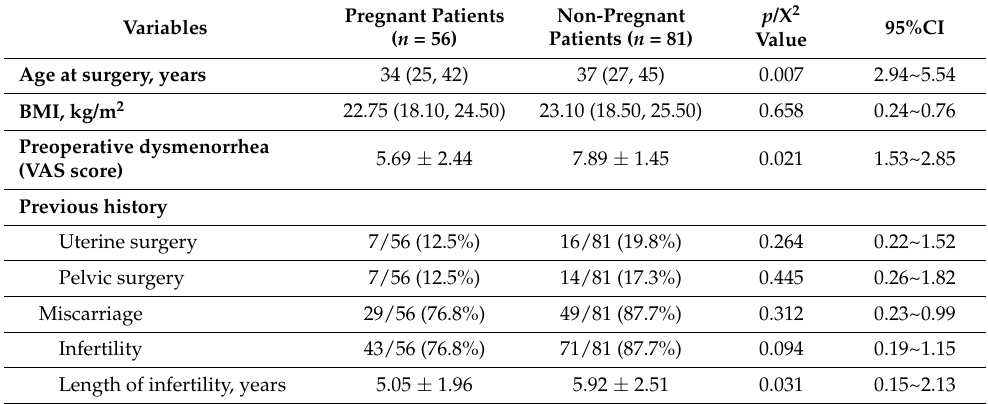
Table 1. Comparison of baseline characteristics between pregnant and non-pregnant patients ( n = 137).